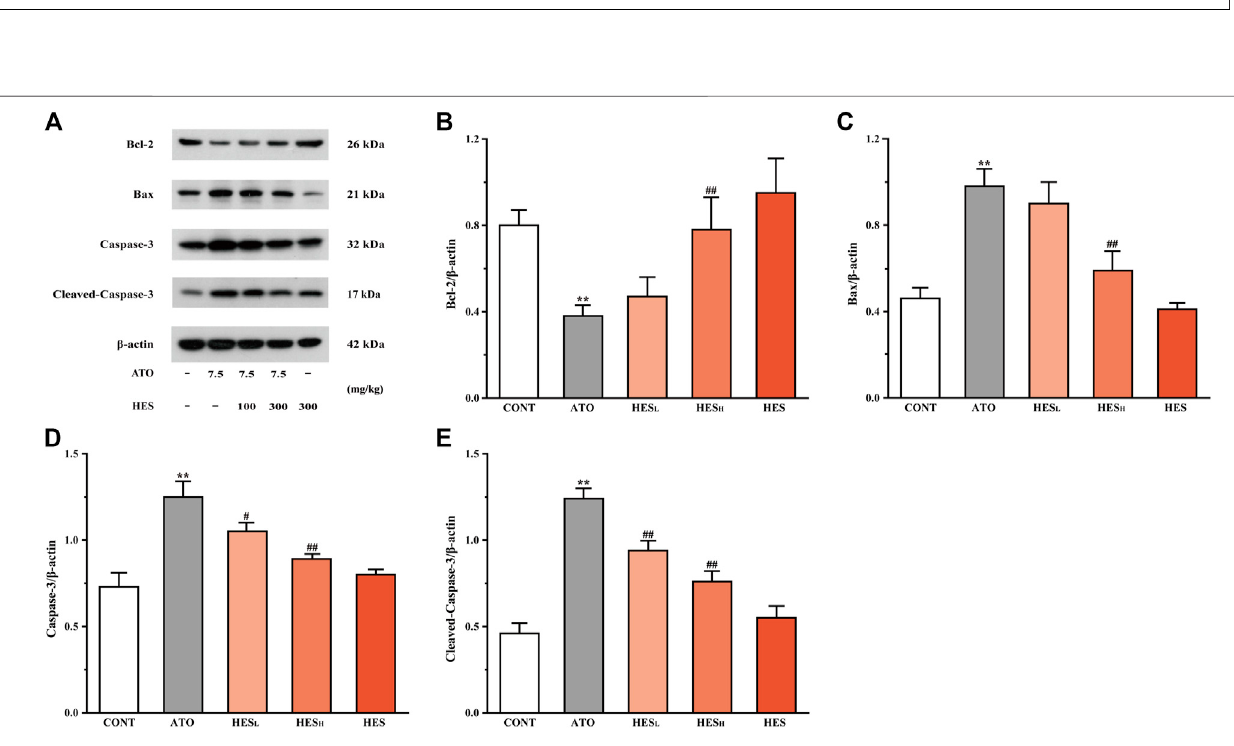
Frontiers in Pharmacology |